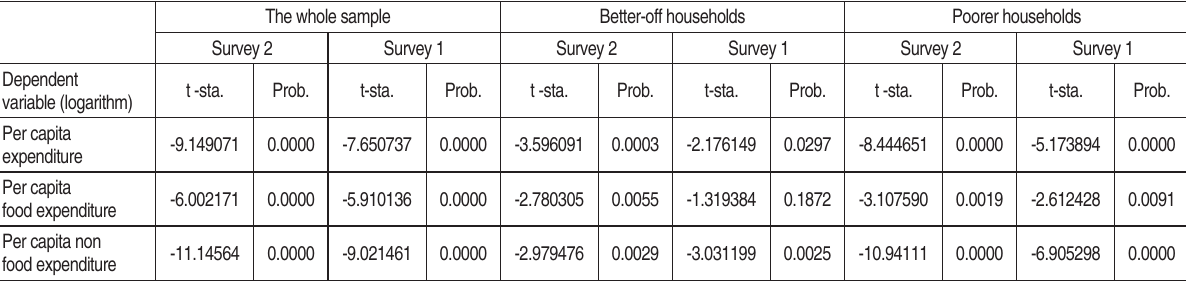
Table 2. Results of Durbin-Wu-Hausman tests